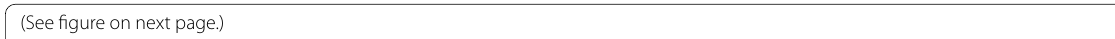
(See figure on next Fig. 1 A Drugs tested (with antimicrobial class and drug displayed on the y axis) and microbiological susceptibility results for Escherichia coli , Enterococcus faecium and Enterococcus faecalis are shown in green color on the x axis. *Indicates antimicrobial class used to determine multidrug resistant status defined as resistance to 1 agent in 3 antimicrobial categories per Magiorakos et al. [27]. Amoxi/Clav Amoxicillin/clavulanate; ≥ ≥ Pip/Tazo Piperacillin/Tazobactam; TMS trimethoprim/sulfamethoxazole. B ABRx Panel results (Diatherix‑Eurofins, Hunstville, AL): 17 antimicrobial resistance genes and corresponding drugs (shown in blue) to which bacteria would show resistance if gene is present